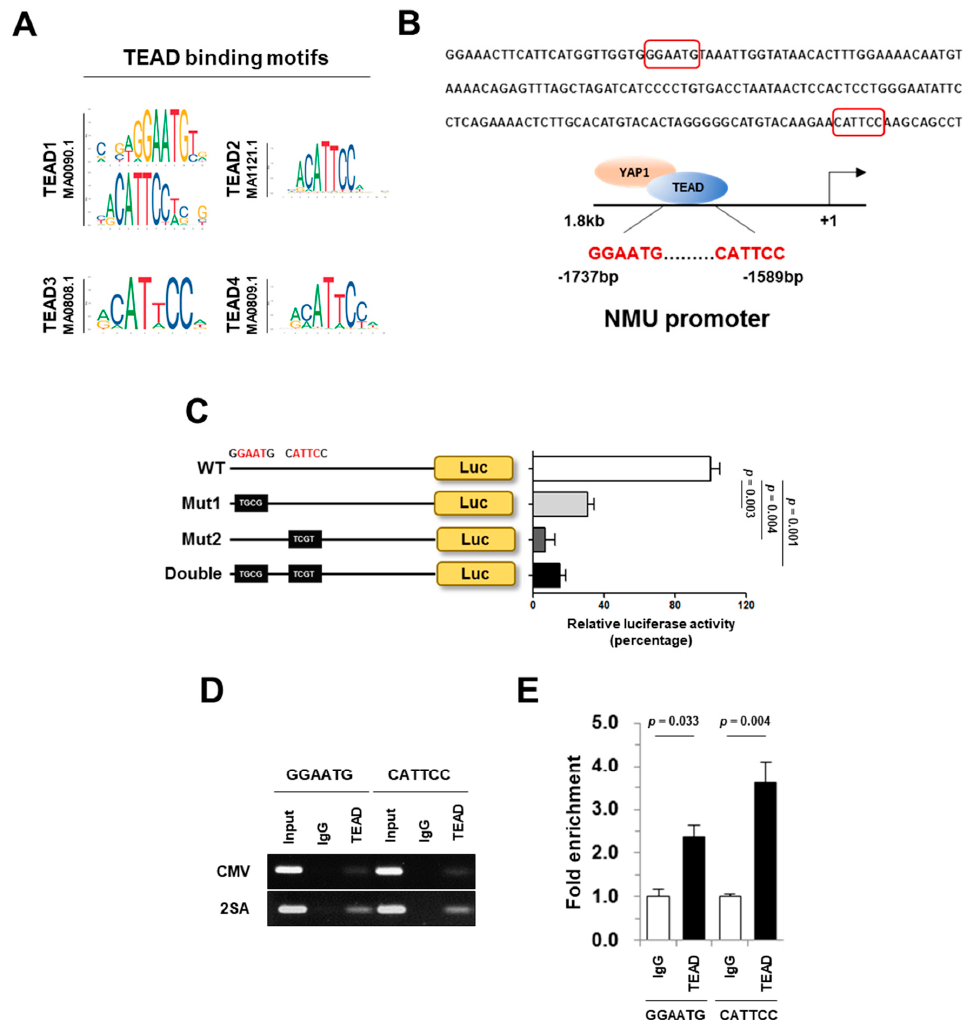
Figure 6. NMU is transcriptionally activated by transcriptional enhanced associate domain (TEAD).